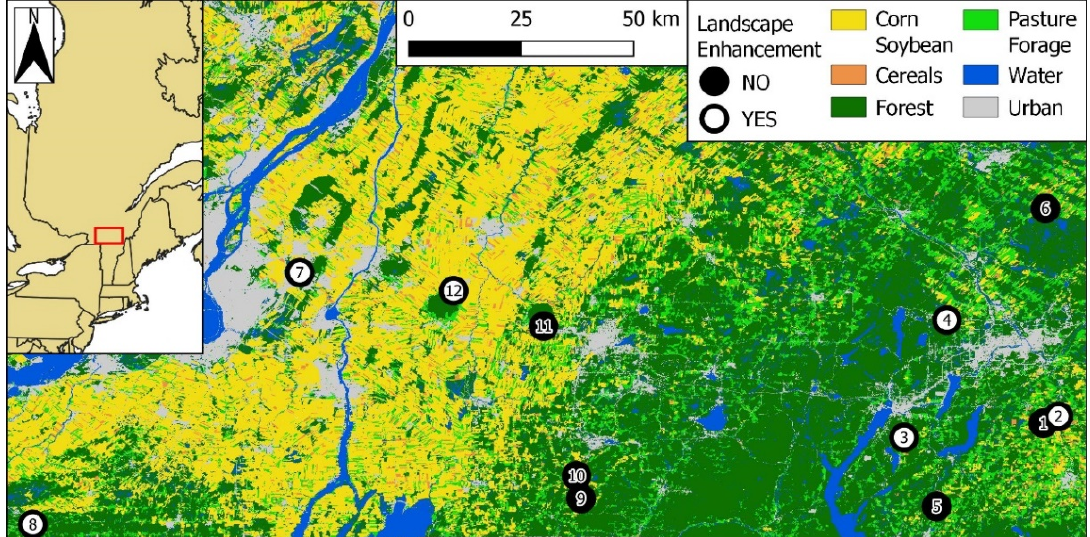
Figure 1. Apple orchards (n = 12) wherein bumble bee communities were monitored between 2017 and 2019 in southern Quebec, Canada. Orchards in the western cluster are in the Mont é r é gie-Est region (#7 to 12); those in the eastern cluster are in the Estrie region (#1 to 6). White and black dots represent orchards with and without landscape enhancements, respectively. Orchard ID numbers are included in the dots. Coordinate system: WGS84 (EPSG 4326). Source: underlying raster based on the Annual Crop Inventory of Agriculture and Agri-food Canada